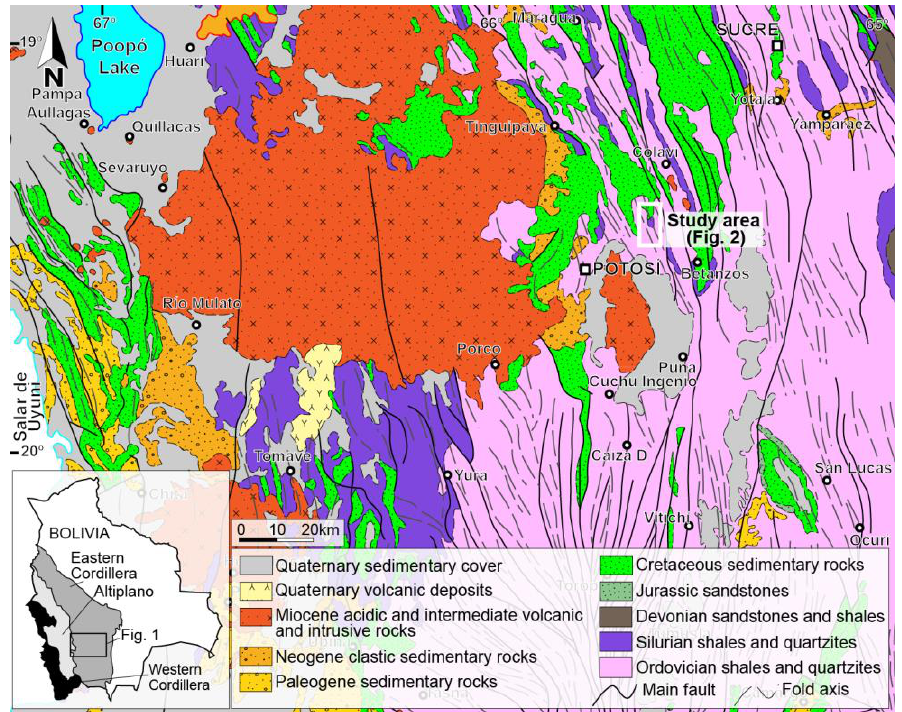
Figure 1. Regional geological map showing the location of the study area (Huari Huari deposit: white box). Inset shows the location of the map within the Eastern Cordillera (Andean morphotectonic units are after Arce-Burgoa [26]).